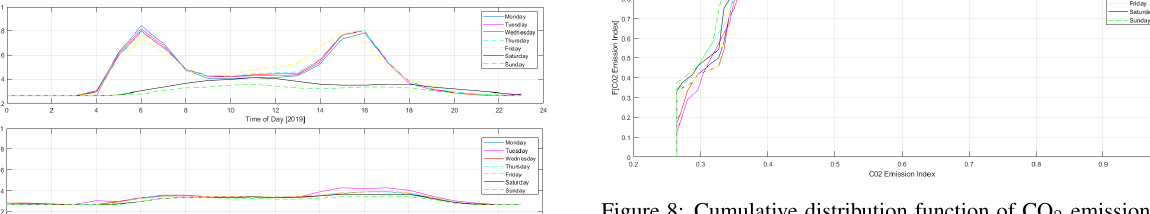
Figure 8: Cumulative distribution function of CO 2 emission in- dex during a lock-down week in